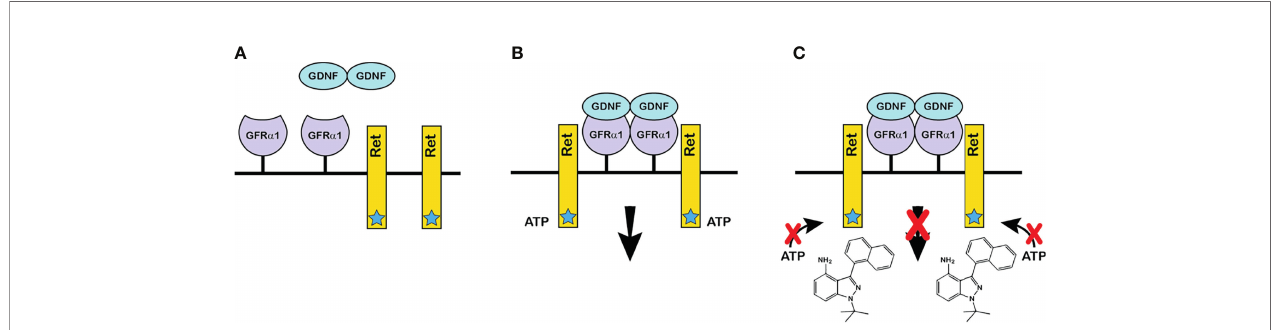
FIGURE 1 | The chemical-genetic approach to reversible inhibition of GDNF signaling in vivo . (A) GDNF and the components of the GDNF receptor: GDNF is secreted as a disul fi de-bonded dimeric protein (17). GFR a 1 is the ligand binding subunit of the GDNF receptor, which is linked to the plasma membrane by glycosylphosphatidylinositol (18). Ret is the receptor ’ s protein kinase subunit. The star on Ret denotes the enlarged ATP binding pocket of Ret(V805A). (B) The GDNF receptor-ligand complex and the initiation of intracellular signaling: Dimeric GDNF cross-links two GFR a 1 receptor subunits, which then recruit two Ret receptor subunits. Formation of the ligand-tetrameric receptor complex stimulates Ret kinase activity, and Ret-bound ATP donates a phosphate to tyrosine residues on the intracellular domain of Ret. Phosphorylation initiates an intracellular signaling cascade. The V805A mutation has no effect on normal Ret kinase activity. (C) How the chemical-genetic approach works: The bulky ATP-competitive inhibitor, 1NAPP1 (structure shown on fi gure) binds with high af fi nity to the ATP binding pocket of Ret(V805A). Consequently, 1NAPP1 prevents RET phosphorylation. Daily injections of 1NAPP1 are suf fi cient to inhibit GDNF signaling but signaling is restored when injections